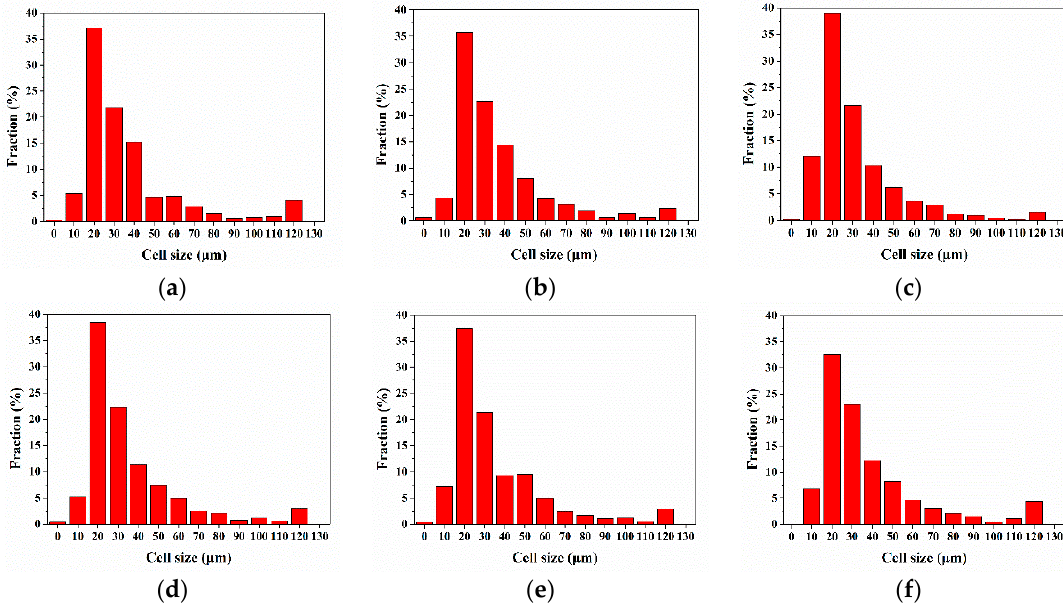
Figure 11. Cell size distribution of vertical sections with different nano-CaCO 3 content: ( a ) 0 wt %; ( b ) 2 wt %; ( c ) 4 wt %; ( d ) 6 wt %; ( e ) 8 wt %; ( f ) 10 wt %.